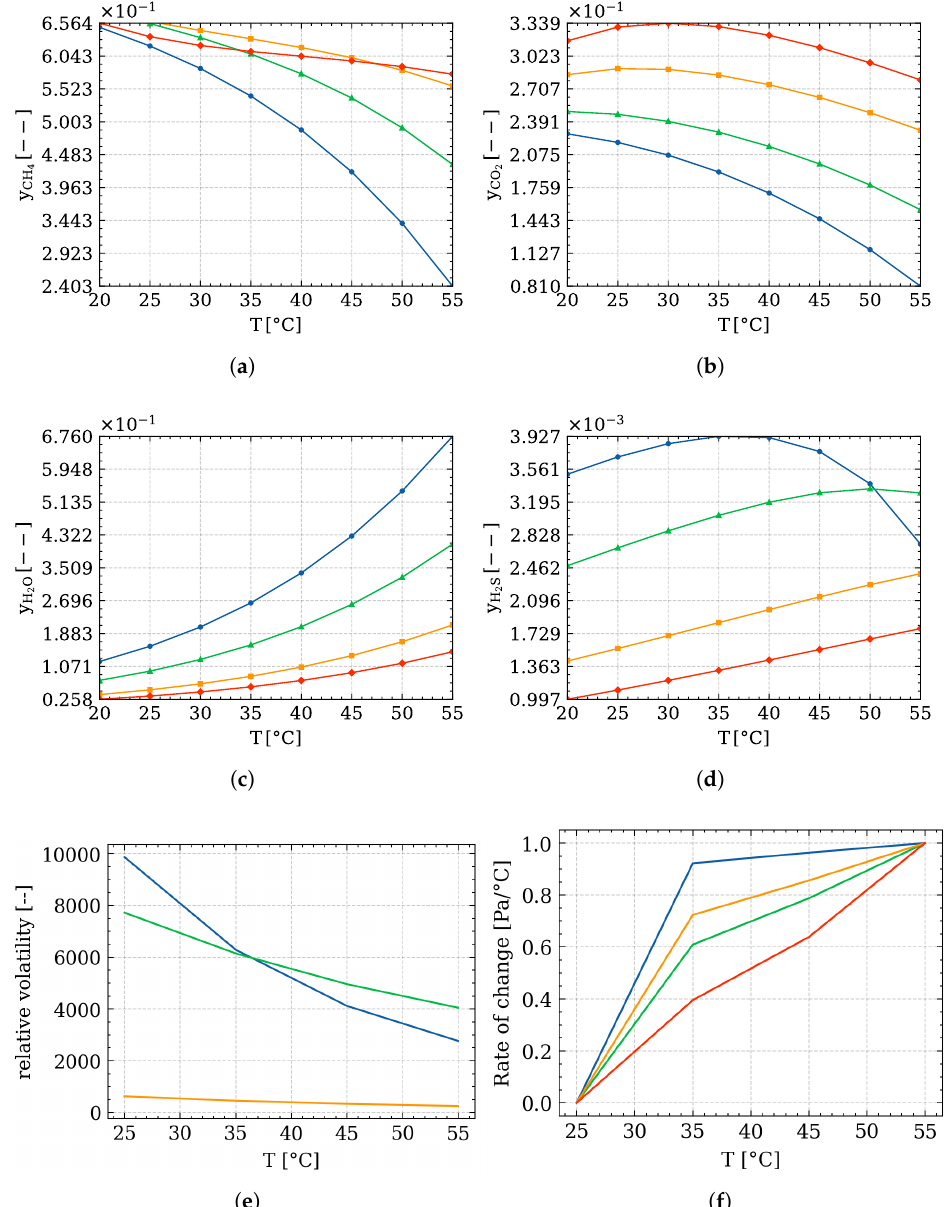
Figure 6. Trends of the vapour phase composition with respect to temperature and pressure of: ( a ) CH 4 , ( b ) CO 2 , ( c ) H 2 O, ( d ) H 2 S, evaluated through Equation (12) at pressure: ( ) P = 0.3 atm, ( ) P = 0.5 atm, ( ) P = 1 atm, ( ) P = 1.5 atm; ( e ) trends of the relative volatility of the light-key species and ( f ) the relative rate of change of the saturation pressure with respect to ) H 2